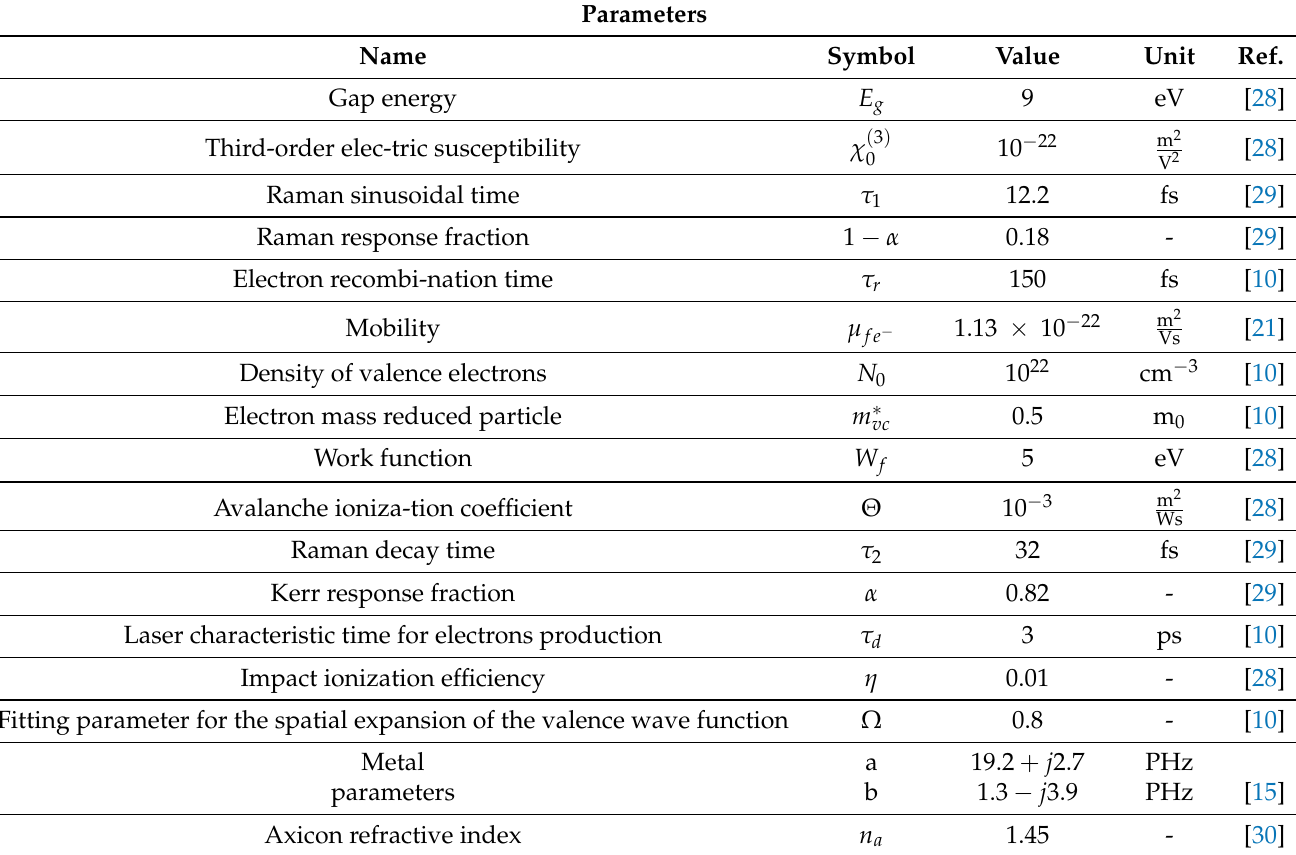
Table 3. Media main